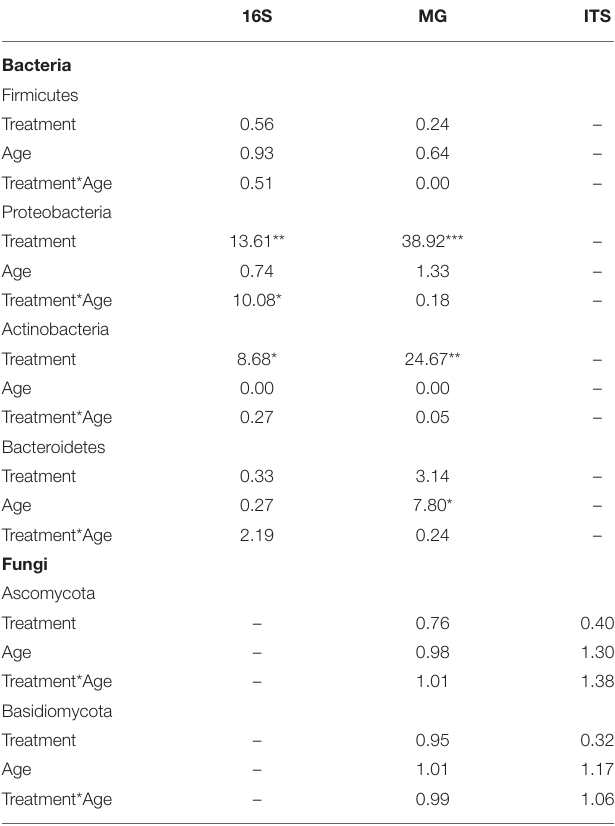
TABLE 1 | Linear model (LM) analyses of phylum abundances for bacteria and fungi from metatatoxonomic (16S and ITS) and metagenomic (MG)